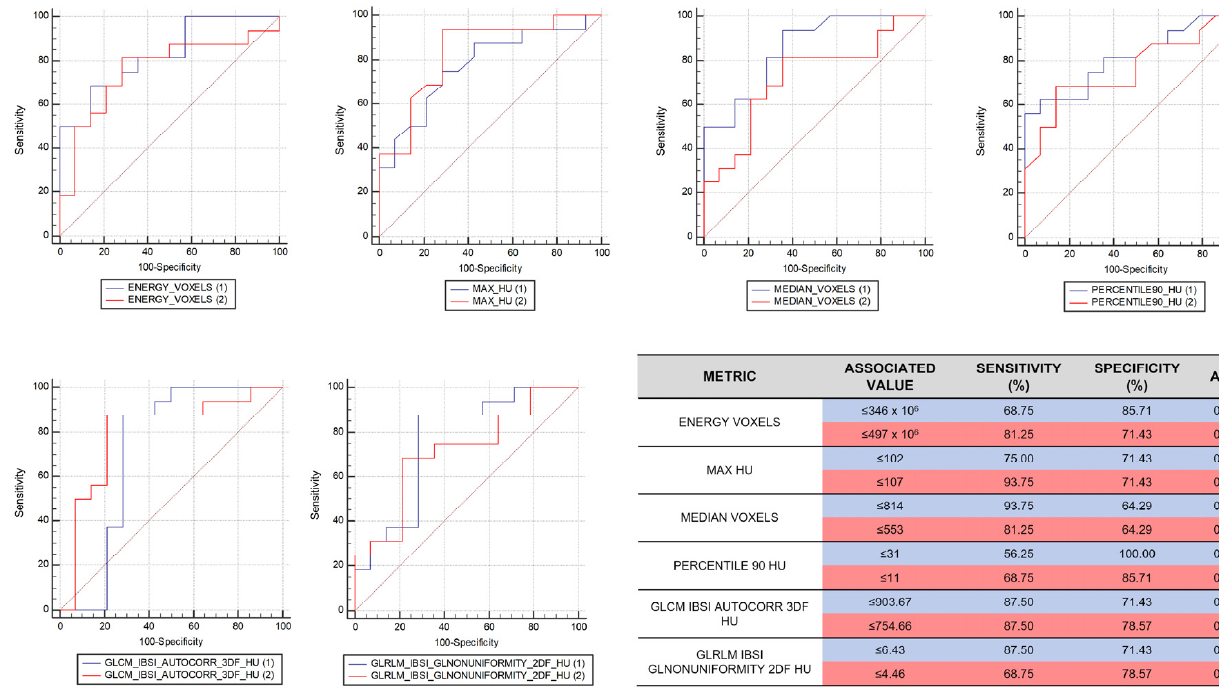
Figure 5. The (ROC) curves for each selected feature. In the table on the right, the values, the sensitivity, the specificity, and the Area Under Curve (AUC) of each relevant feature are reported. In both ROC curves and rows of the table, the blue color represents the results obtained by the first radiologist, while the red color is related to the second